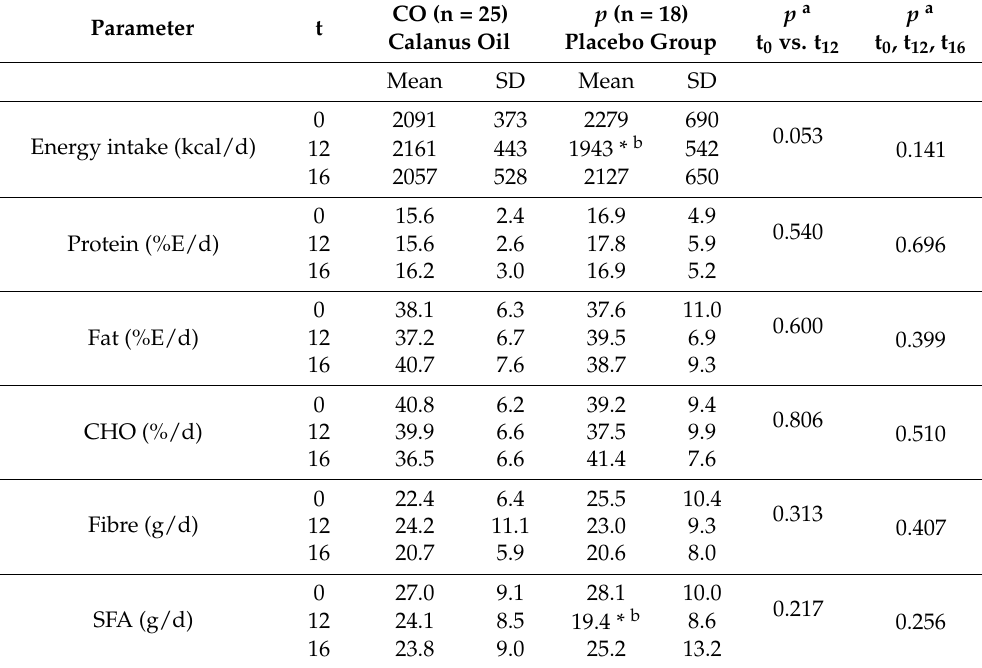
Table A2. Daily dietary intake calculated from 3-day dietary records at the beginning (t0), after 12 (t12) and 16 (t16) weeks of